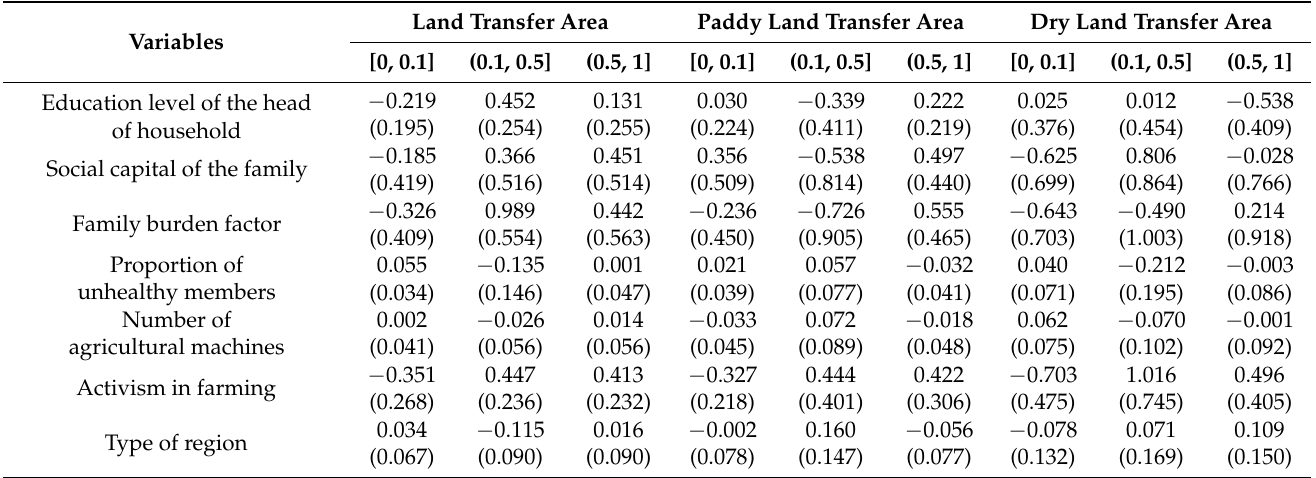
Table 5. Generalized propensity score matching balance test for the months of per year non-farm employment per